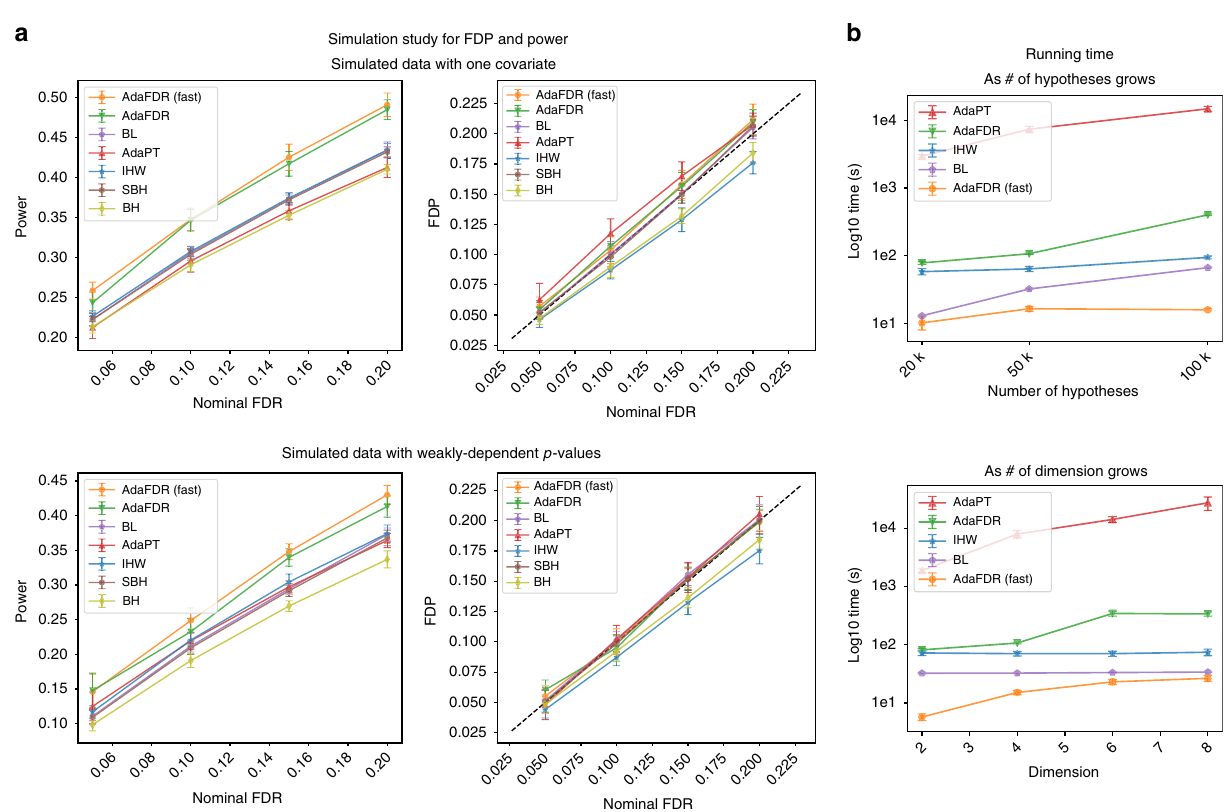
Fig. 4 Simulation studies. 95% con fi dence intervals are provided for all panels. a Simulation of FDP and power on an independent case (top) and a weakly- dependent case (bottom). b Running time analysis. Top: as the number of hypotheses grows. Bottom: as the covariate dimension